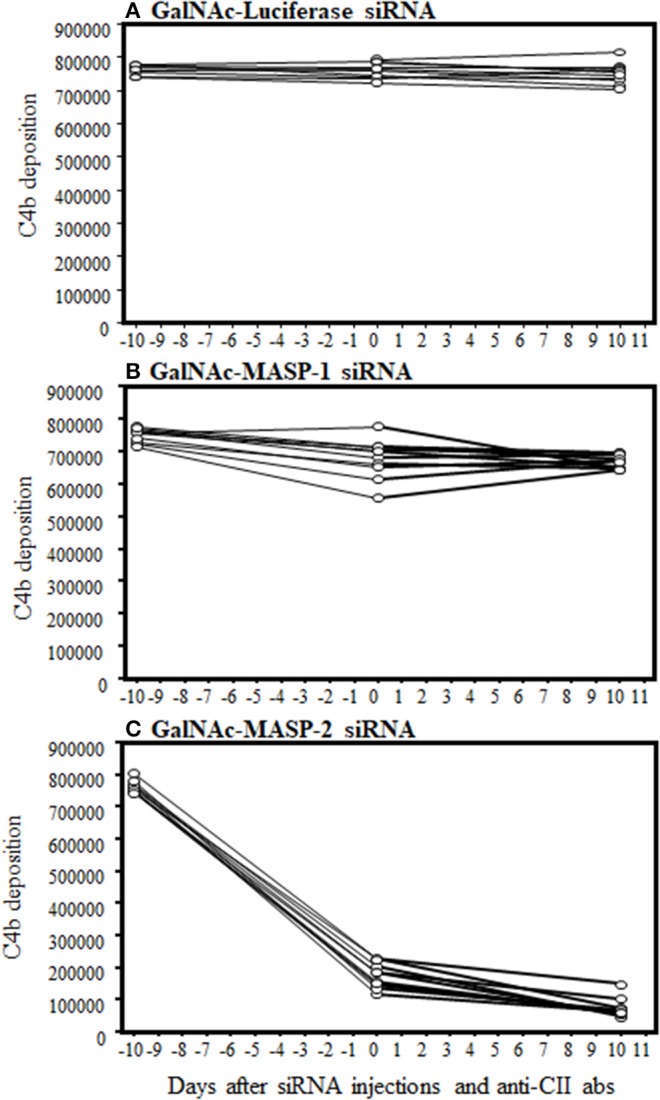
ELISA showing a large decrease in C4b deposition on mannan in the sera from arthritic mice treated three times with GalNAc-MASP-2-siRNA but not with GalNAc-MASP-1-siRNA or GalNAc-Luciferase-siRNA. Sera from mice treated with MASPs or control siRNAs as mentioned above were diluted 1/500 in a tris/high salt/calcium buffer (inhibit any activation by the classical or the MBL pathway) examined at day-10 (before siRNAs injection & before disease induction), day 0 (after injection but before disease induction) and at day 10 (after disease induction). Human recombinant C4 protein was used to show the cleavage into C4b by MASP-2 (mouse MASP-2 bound as MBL/MASP-2 complexes onto the mannan efficiently cleaves human C4—and C4b becomes bound) followed by detection with anti-C4 antibody as mentioned in the Materials and Methods. No change in C4b deposition in the sera from arthritic mice treated with (A) GalNAc-Luciferase-siRNA (B) GalNAc-MASP-1-siRNA. (C) A substantial decrease in C4b deposition in the sera from mice treated GalNAc-MASP-2-siRNA. Data from all individual mice treated with GalNAc-Luciferase-siRNA (n = 10) or GalNAc-MASP-1-siRNA (n =10) or GalNAc-MASP-2-siRNA (n =10) have been shown. p < 0.05 at day 0 and at day +10 vs. at −10 mice injected GalNAc-Luciferase-siRNA, GalNAc-MASP-1-siRNA and GalNAc-MASP-2-siRNA.